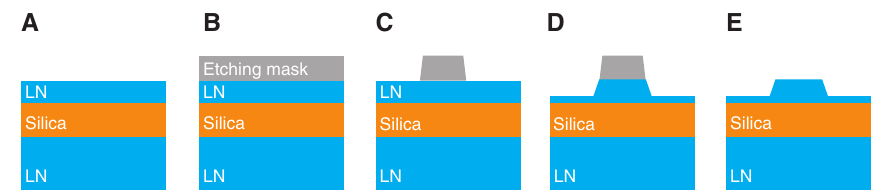
Figure 3: A standard dry etching process of